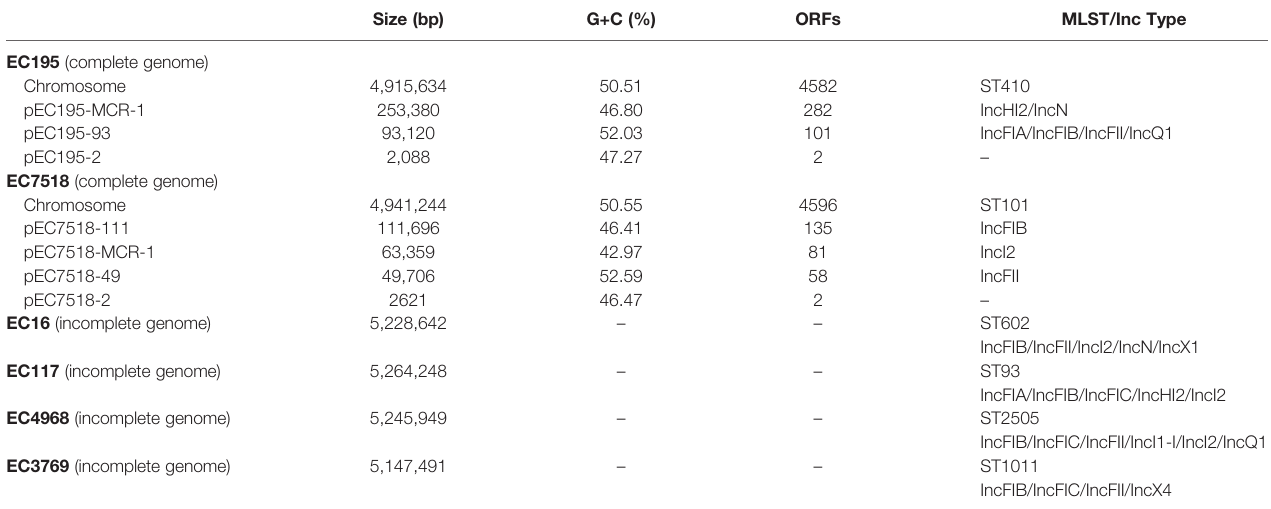
TABLE 2 | General features of the genomes of the mcr-1 -positive E. coli strains.